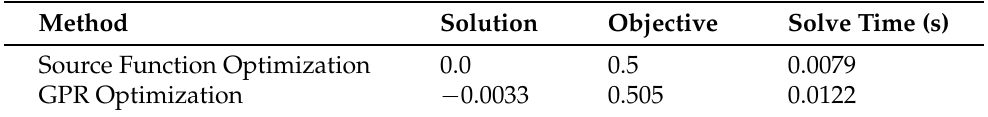
Table 3. Optimization results for benchmark